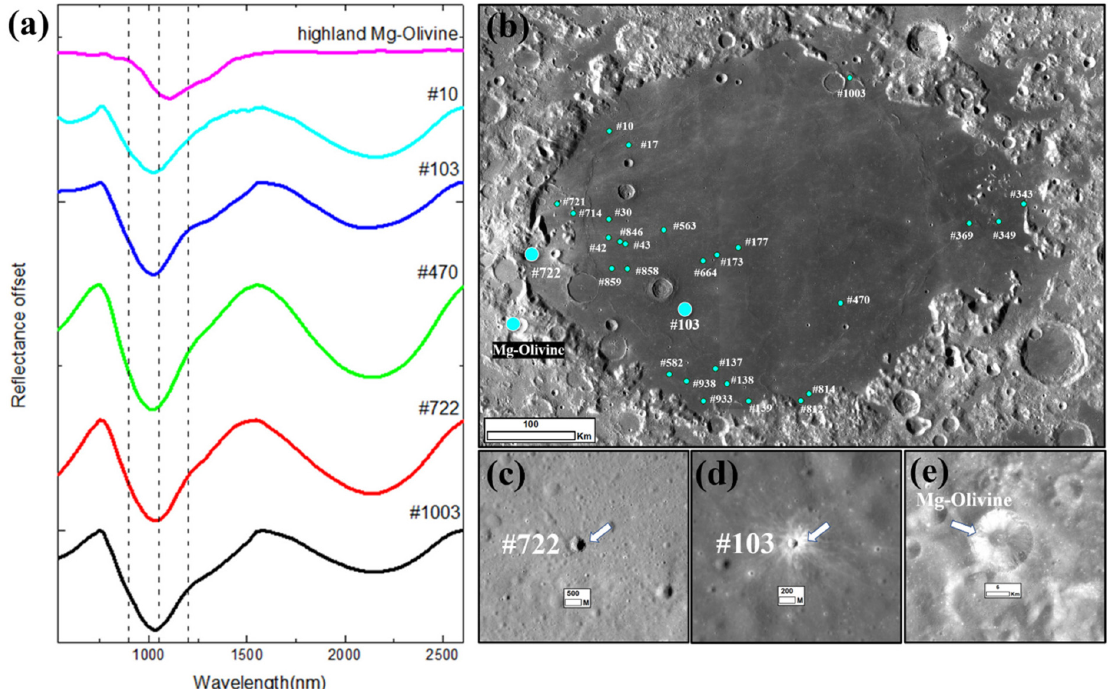
Figure 11. ( a ) The continuum-removed spectra of small fresh craters exhibit a broad absorption at 1000 nm, which indicates an olivine-rich component. Three dashed lines are the absorption centers of olivine near 900 nm, 1050 nm, and 1200 nm, respectively. ( b ) The positions of these craters are labeled in the Crisium basin. The insets of ( c ) #722, ( d ) #103, and ( e ) an exposure of olivine in highland massifs in Figure 11b demonstrate the topography of these olivine-rich